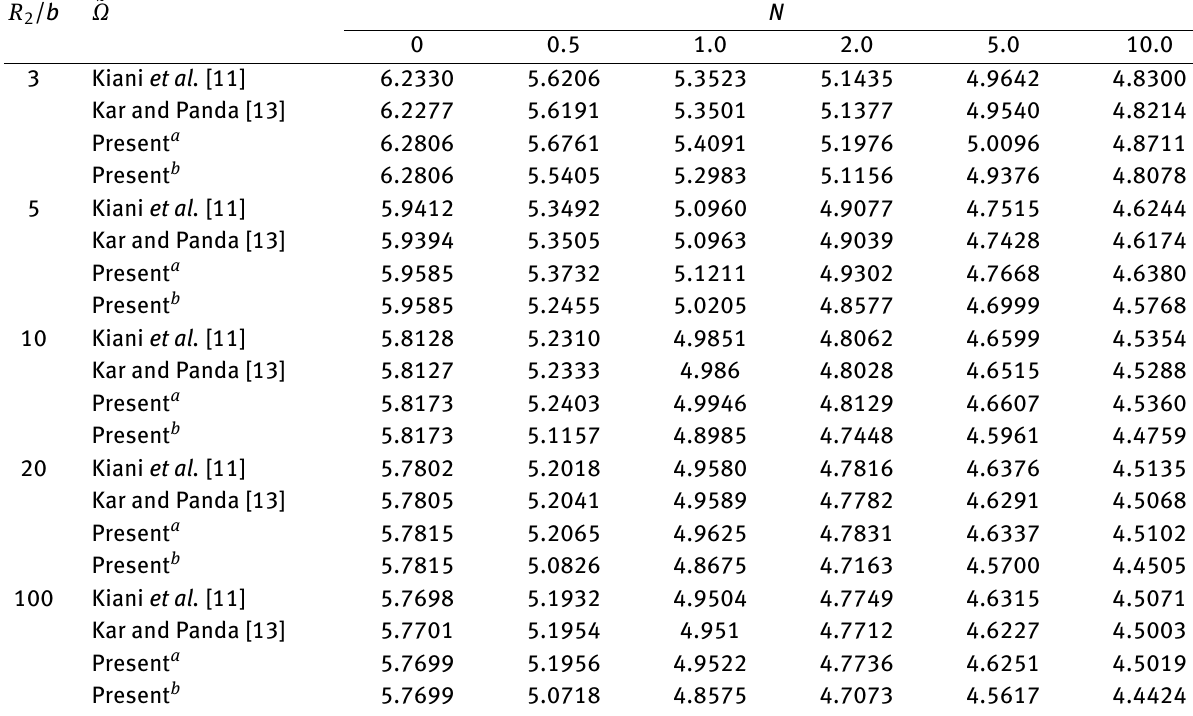
Table 4: Comparisons of fundamental frequencies ˜ ω = Ω ( b 2 / h ) √︀ ρ c / E c for double curved Al/ZrO 2 panels ( a/b = 1, b/h = 10, R 1 = 2 R 2 ) R 2 /